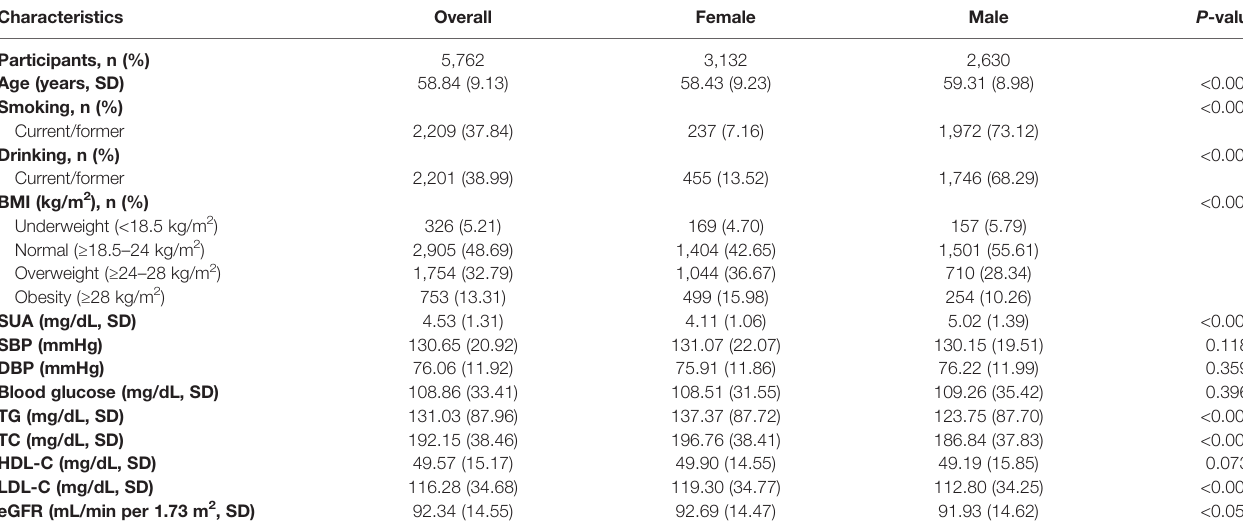
TABLE 1 | Characteristics of participants at